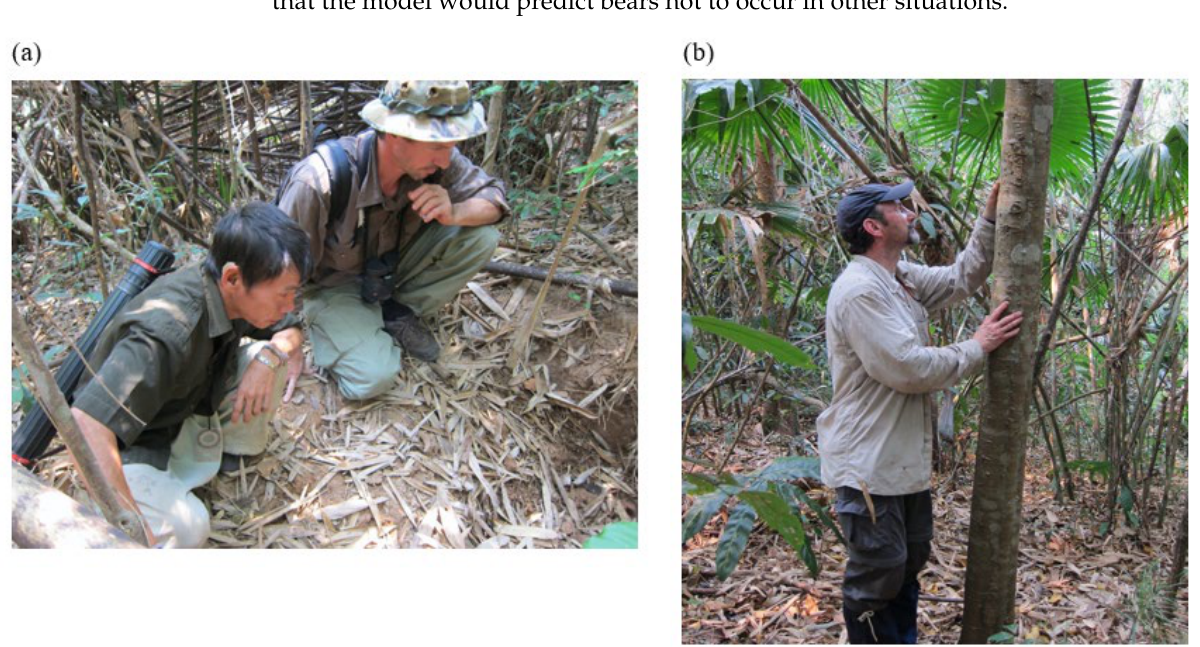
Figure 3 . Many habitat studies of bears are based on presence points identified from sign. ( a ) A sampling problem arises when uncertain sign is either incorrectly counted as a bear, or always discounted. ( b ) Relying only on definitive sign, such as claw marks on trees prevents identification errors, but may create a bias towards habitats where bears create more of that type of sign (e.g., habitats with many fruit trees that bears climb). Photos: D. Garshelis; R. Steinmetz.